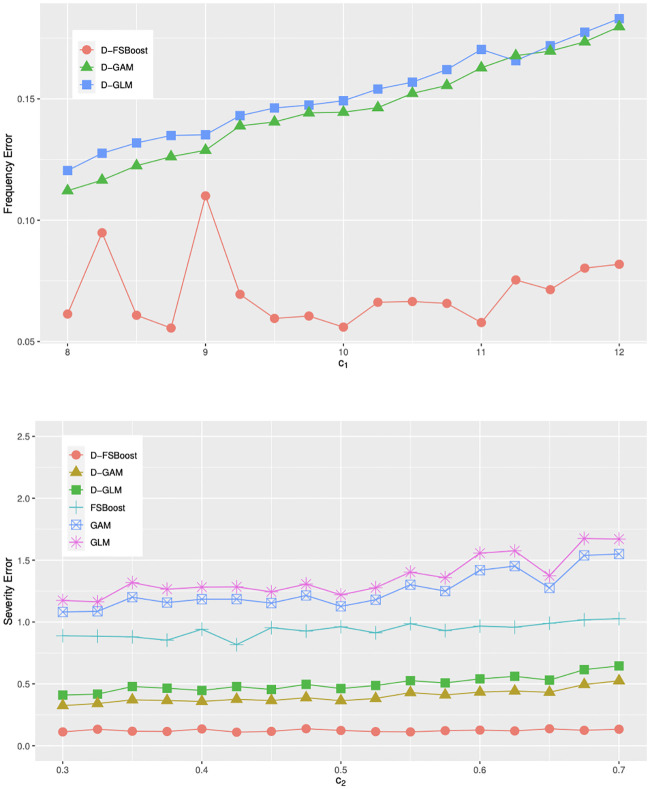
Parameter estimation errors w.r.t. c1 and c2.